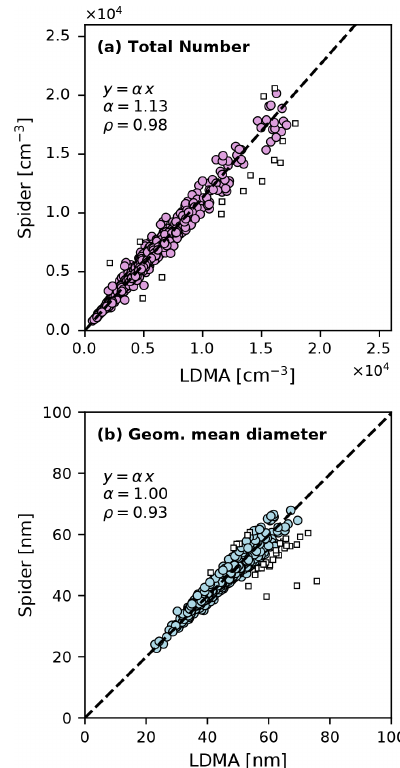
Figure 8. Comparison of (a) total particle number and (b) geometric mean diameter measured by the Spider and LDMA systems over a period of 26d of continuous testing. Each point represents 1h aver- aged data, calculated over the 17–500nm size range where the two instruments overlap. Square symbols show outliers excluded from the regression analysis. Dashed lines represent a linear regression model (no intercept) fitted to the data. ρ values denote the Pearson correlation coefficient between the measurement data of the two in-